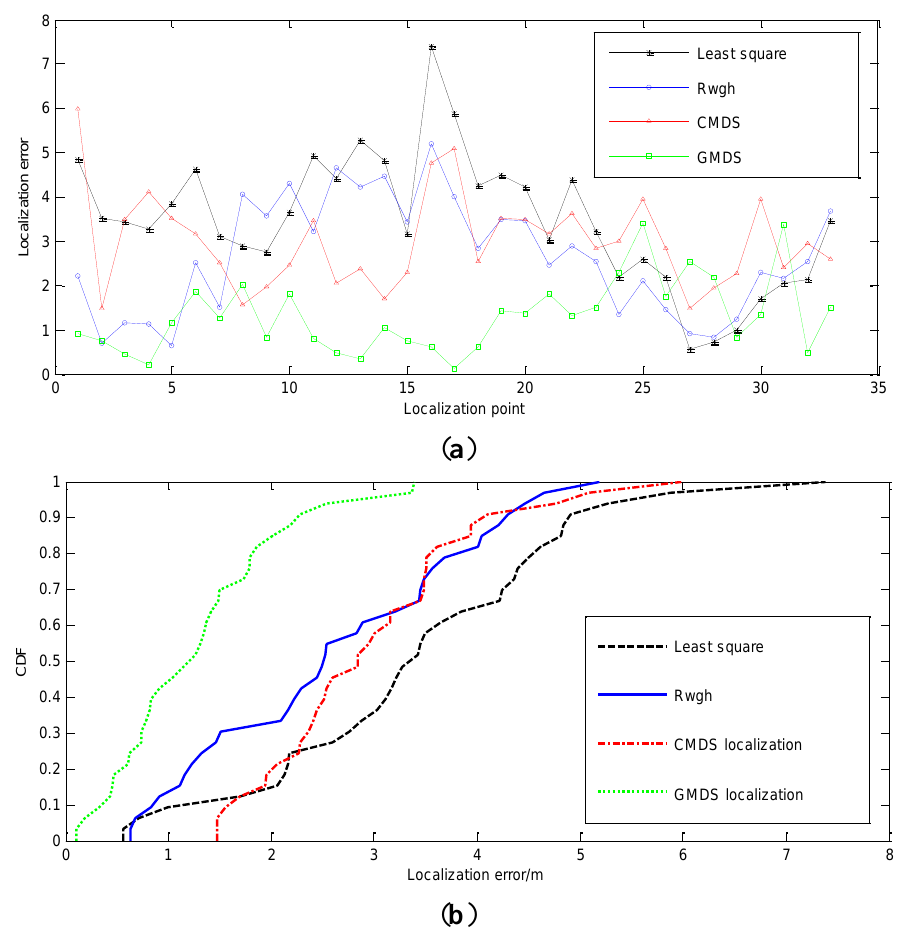
Figure 7. Performance of the tracking algorithms when 2 2 N  ; ( b ) Diagram of cumulative error distribution when 2 nlos